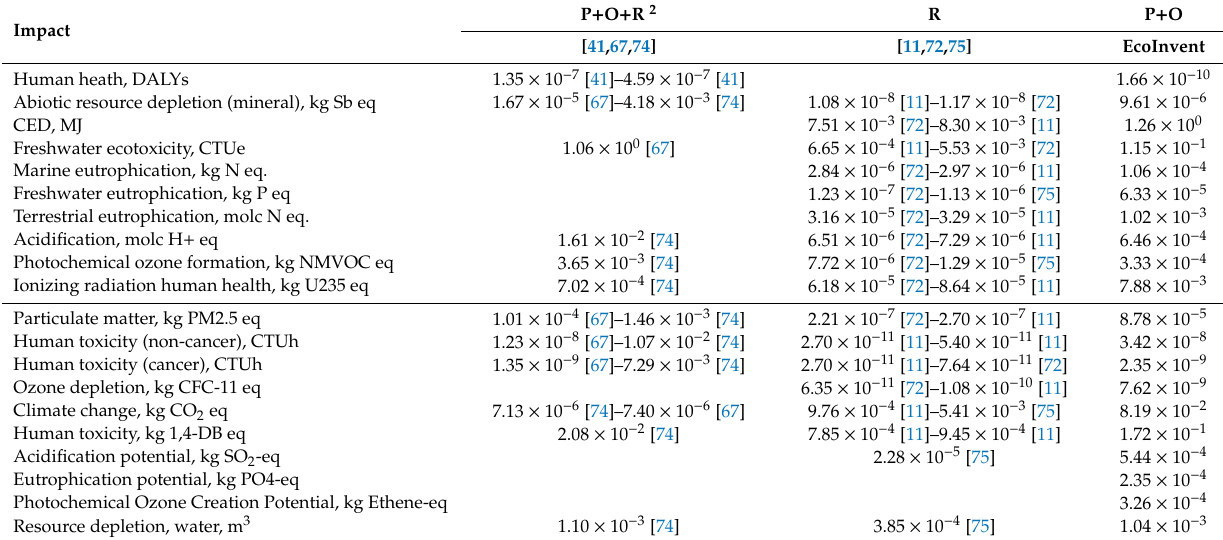
Table 3. Environmental impacts of di ff erent life cycle stages of c-Si PV panels (for 1 kWh 1 ).